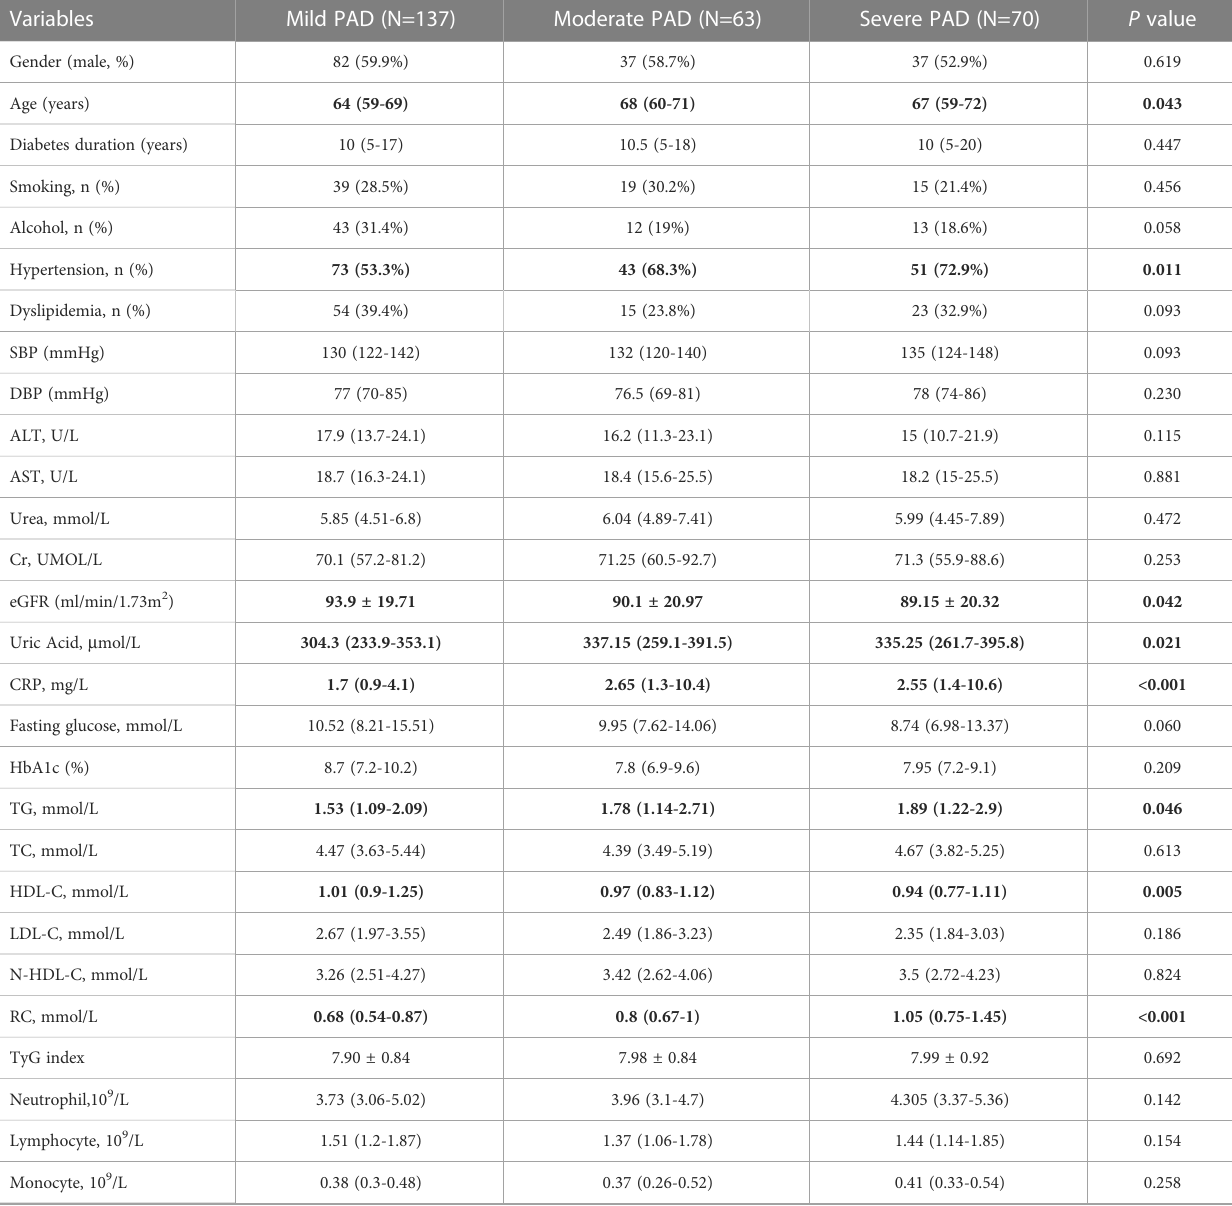
TABLE 2 Demographic and clinical data of T2DM – PAD group according to PAD